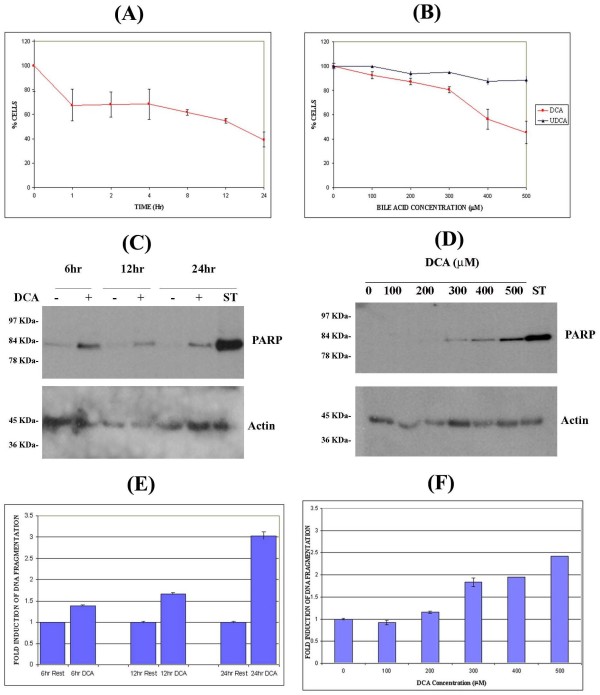
DCA induces PARP cleavage and DNA fragmentation with reduced cell proliferation in SKGT4 cells. SKGT4 cells were incubated with 300 μM DCA at the indicated time intervals (A) and at DCA concentrations ranging from 0 – 500 μM for 6 hours (B). In panels A and B, cellular proliferation was assessed using the MTT assay as described in experimental procedures. Results are expressed as percentage of proliferating cells relative to untreated controls. Mean ± SD. To investigate DCA induced PARP cleavage (C,), SKGT4 cells were stimulated with 300 μM DCA for the indicated times or with 0 – 500 μM DCA for 6 hr (D). 1 μM Staurosporine (ST) was used as positive control. In panels C and D, total cell lysates were standardized to 50 μg as described in experimental procedures and assessed by Western blotting using an antibody directed against cleaved PARP to detect apoptosis. Anti-actin antibody used as loading control. SKGT4 cell lysates were assessed for DNA fragmentation as described in Methods (E, F). Results are presented as fold induction of DNA fragmentation relative to unstimulated control. Mean ± SD.